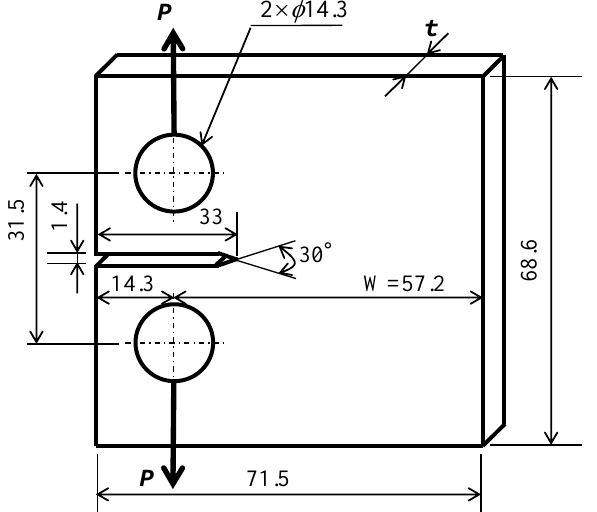
Figure 2. Shape and dimensions of ASTM standard compact tension (CT) specimens ( W = 57.2 mm; thickness t = 1, 6, 11, and 21 mm).